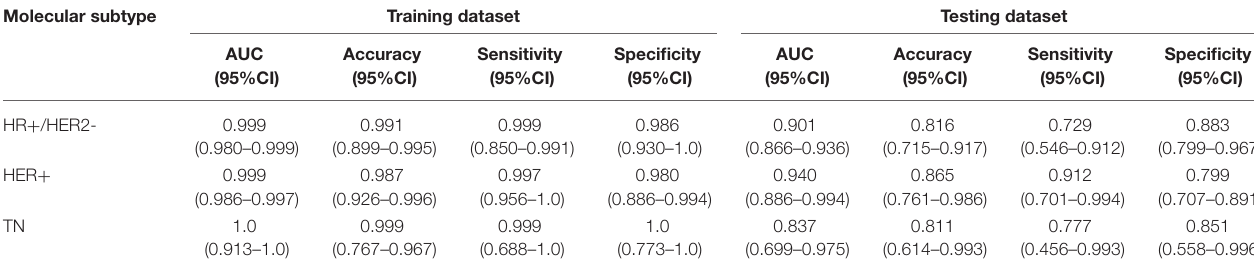
TABLE 4 | Performance to classify tumor shrinkage pattern in three molecular subtypes. Molecular